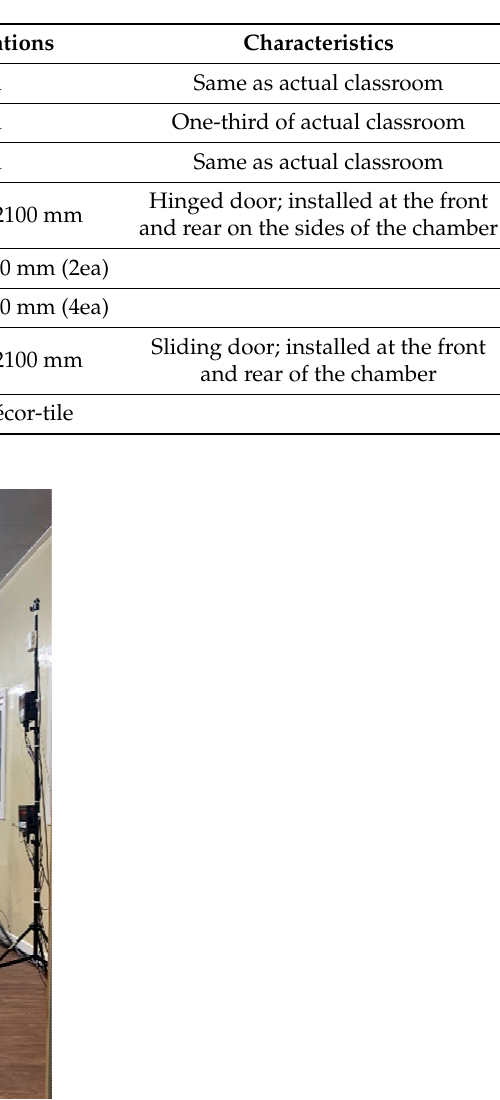
Table 1. Design specifications of the classroom chamber.